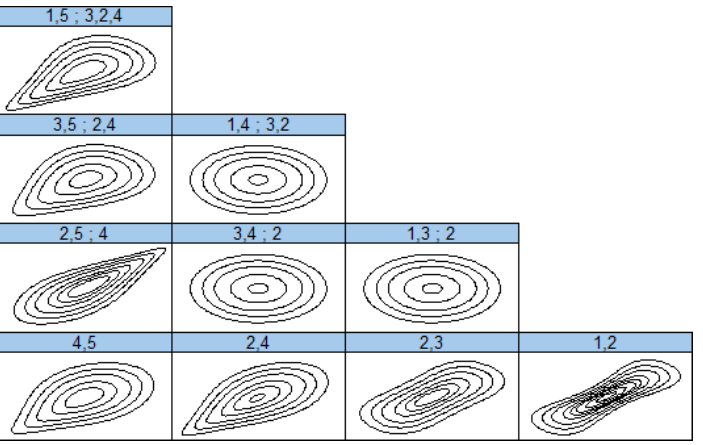
Figure 5. Fitted R-vine normalized contour plots of the specified pair copulas for the volume